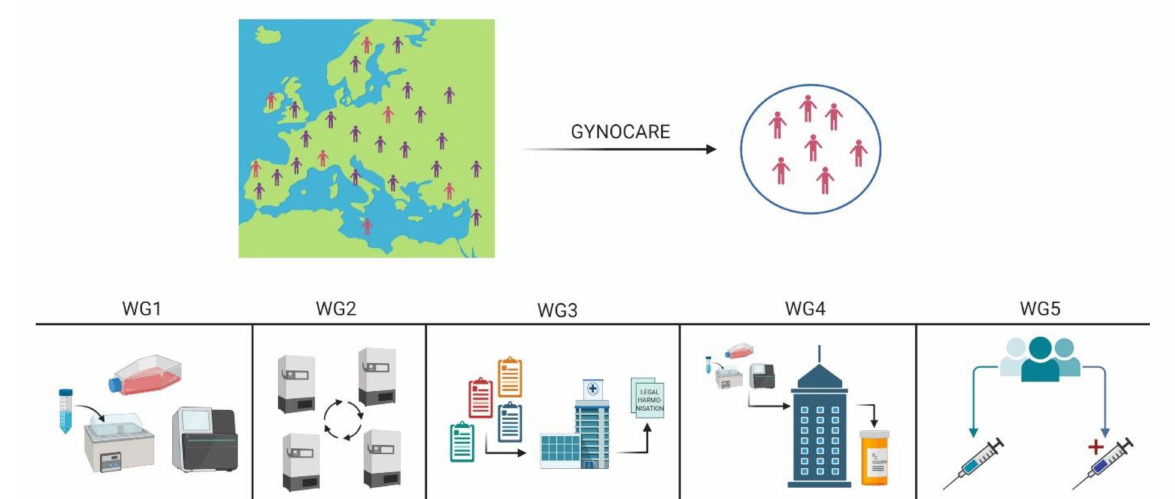
Figure 1. Description of the GYNOCARE COST Action CA18117. The main aim and objective of the Action is to create a European platform for Gynaecological Rare Cancer research to bridge the gap from concept to cure (connect basic research to biobanking to clinical trials). GYNOCARE has devised 5 Working Groups (WGs) and each of which contributes to a specific sub-objective and tackles a specific challenge. WG1–Basic Research: Coordination of ongoing and future research activities. The main objective of WG1 is to further develop a well-established network of researchers that impulse research in Gynaecological Cancer, with focus on very rare diseases where the treatments options are scarce. WG2–Coordination of bridging the gap between biobanks and translational research projects: The main objectives of WG2 are to establish a virtual network from the existing European biobanks for rare gynaecological malignancies (using a virtual platform that will allow the real time visualisation of the samples); and to integrate the biobanking concept within the clinical trials and translational research projects running in this field. WG3–Coordinating harmonisation of legal/regulatory requirements for international trials and other collaborative efforts. This WG aims to harmonise the legal requirements requested from the different European countries (all EU countries and non-EU countries within Europe). WG4-Bridging the gap between industry and biotechnology companies and translational research projects. The main objective of WP4 is to introduce GYNOCARE to the Pharma industries and to the companies that are developing commercial tools for diagnosis and prognostic assessment of the patients to showcase the distinct value for trial and study design, while also revealing to potential for smarter drug design and reuse of existing therapeutics. WG5–Coordination of interactions between clinical trials, translational research, and basic research. The main objective of the WP is to connect all the actions and stakeholders to existing and established clinical trial activities. (https://www.cost.eu/actions/CA18117/#tabs\T1\textbar{}Name:overview). Figure created using Biorender